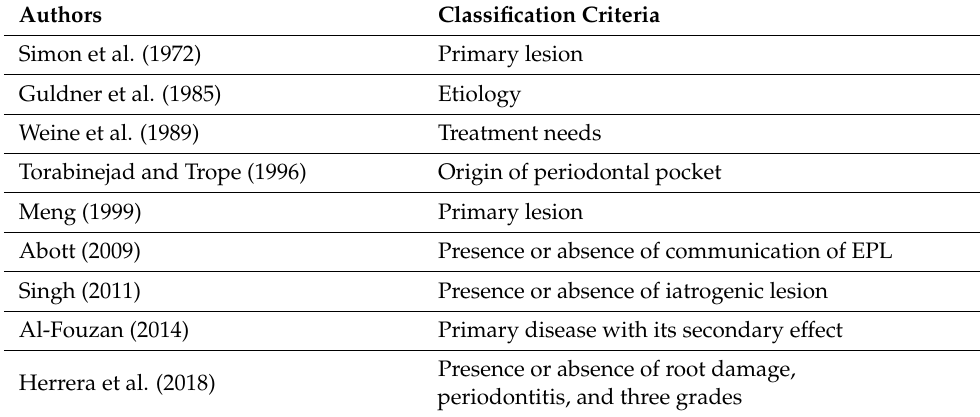
Table 1. Systems for the classification of